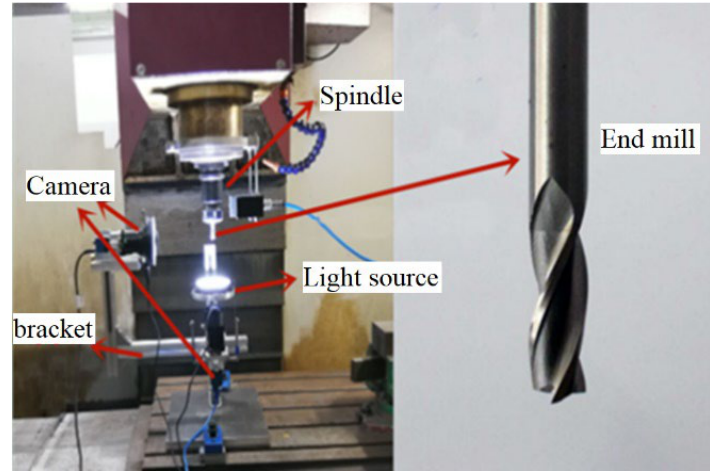
Figure 2. Tool wear detection system.